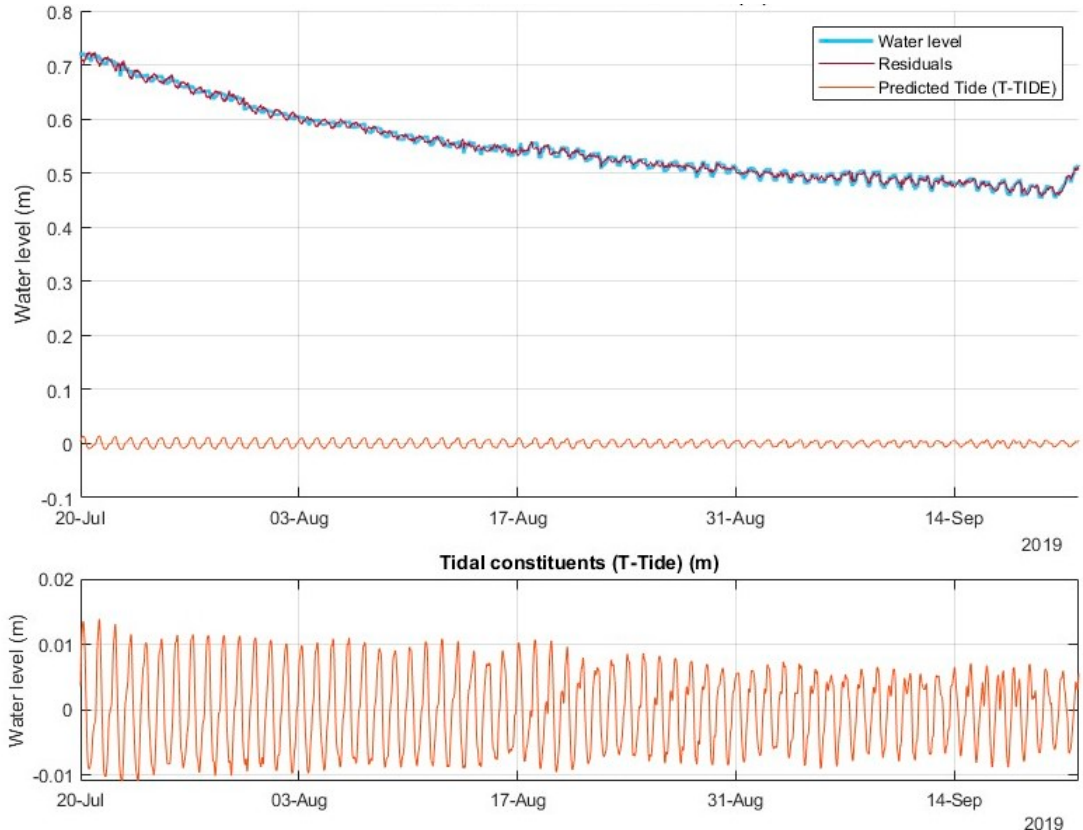
Figure 4. Tidal analysis of water stage for the period of 20 July 2019 till 21 September 2019, showing the predicted tidal component and the residual between the predicted tide and the field data.